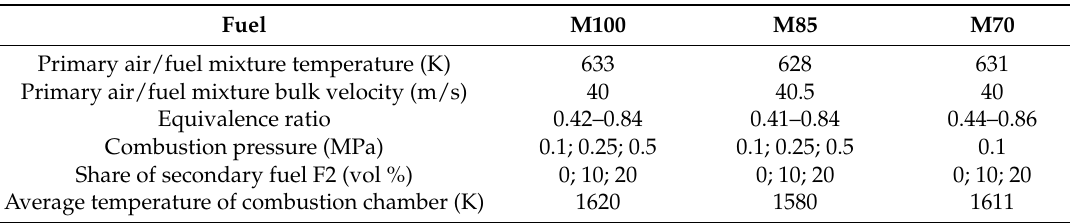
Table 3. Mixture composition and combustion parameters.